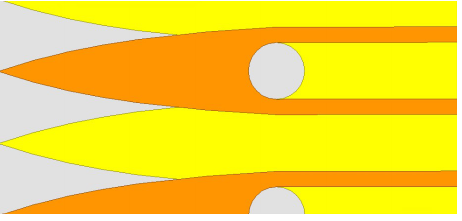
FIGURE 5. Triple Finline in Antipodal